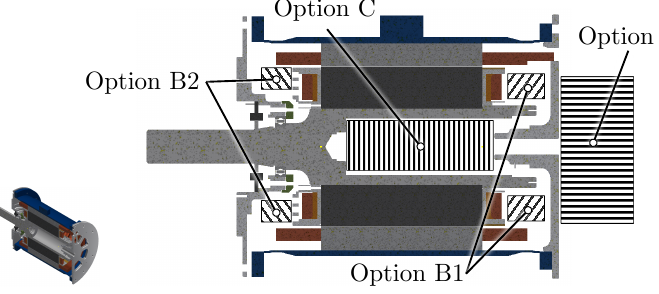
Figure 12. Possibilities for placement of the WPT